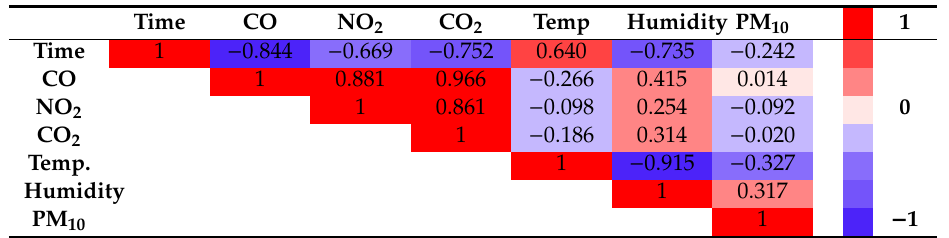
Table 4. Linear correlation matrix for period 2.